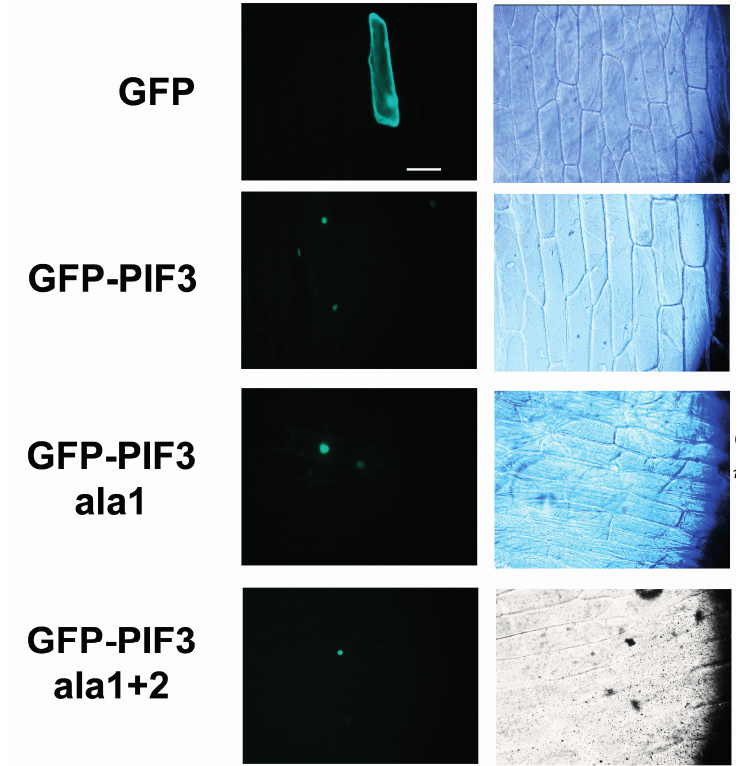
Figure 2. Subcellular localization of GFP, GFP-PIF3, GFP-PIF3ala1 and GFP-PIF3ala1+2. Fluorescence ( left ) and light field ( right ) images of onion epidermis cells bombarded with corresponding DNA are shown. The scale bar indicates 100 μ